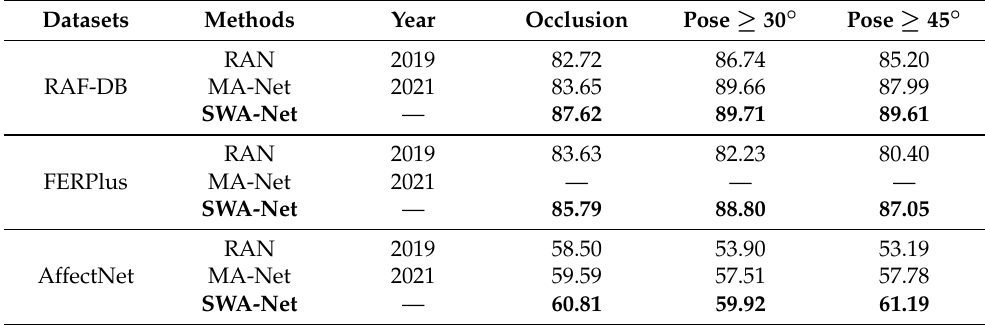
Table 9. Comparisons with the state-of-the-art methods on the Occlusion and Pose datasets.